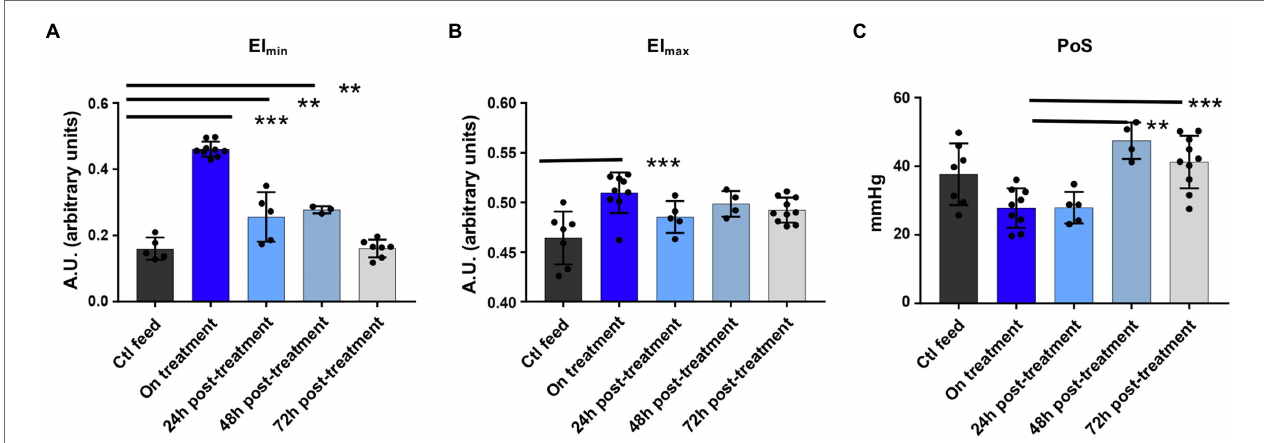
FIGURE 3 | Deformability and point of sickling measurement using oxygen gradient ektacytometry on and off GBT1118. (A) RBC deformability when deoxygenated rises on drug and declines but remains above baseline up to 48 h off drug. Ctl n = 5, on treatment n = 9, 24 h post n = 5, 48 h post n = 3, and 72 h post n = 7. (B) RBC deformability when oxygenated rises on drug. Ctl n = 7, on treatment n = 9, 24 h post n = 5, and 72 h post n = 10. (C) Point of sickling drops on drug and returns to baseline 48 h drug. Ctl n = 7, on treatment n = 9, 24 h post n = 5, 48 h post n = 4, and 72 h post n = 10. *** p < 0.0001; ** p < 0.05. EI max , maximum elongation index; EI min , minimum elongation index; PoS, point of sickling; and RBC, red blood